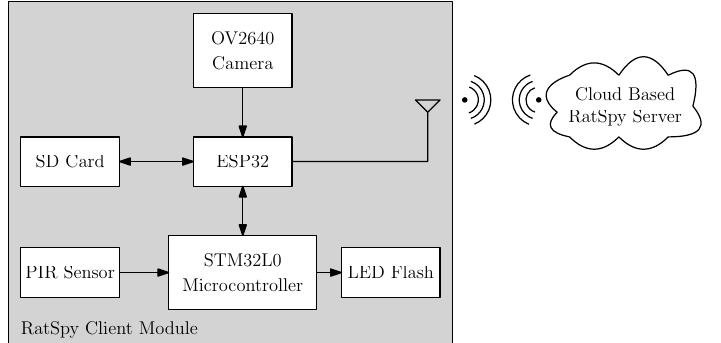
Figure 2. System Block Diagram.